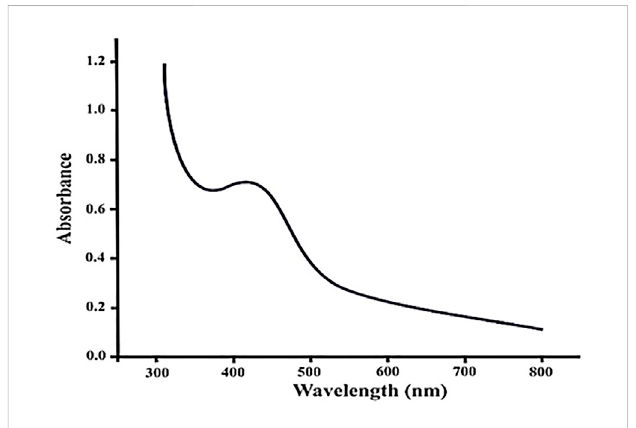
FIGURE 1 UV-visible spectra of silver nanoparticles of Piper cubeba